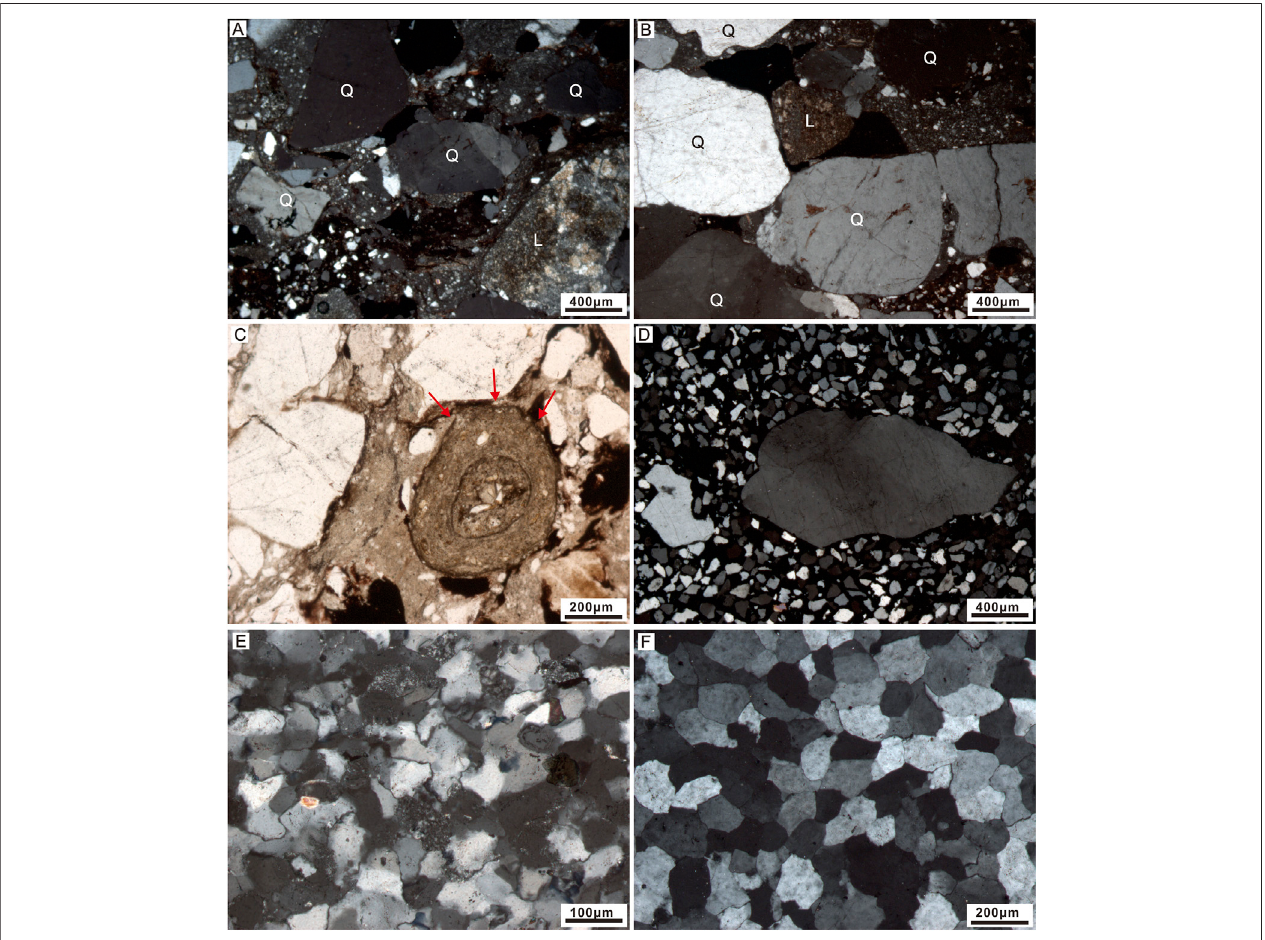
FIGURE 5 | Micrographs of sandstone samples from the Liangshan Formation. (A,B) Photomicrograph (cross-polarized light) of coarse-grained coastal plain channel sandstones from lower Xiuhe section, presenting high contents of silt-grained matrix, generally matrix-supported texture, and poorly sorted subangular to subroundedquartzgrains(Q)andsedimentarylithicfragments(L,carbonate,mudrock,andsiltstone)asframeworkcomponents. (C) Photomicrograph(plane-polarized light)ofcoarse-grainedcoastalplainsandstonesfromXiuhesection,showingaspeci fi cooid-likelithicfragmentwithdifferent-coloredconcentriclaminae(arrowed). (D) Photomicrograph (cross-polarized light) of fi ne-grained coastal plain channel sandstones in lower Xiuhe section, showing well-sorted, subangular to subrounded quartz grains and outsized quartz grains, which range from coarse-grained sand to granules in size. (E) Photomicrograph (cross-polarized light) of fi ne-grained deltaic sandstonesfromtheupperCaohaisection. (F) Photomicrograph(cross-polarizedlight)ofthe fi ne-graineddeltaicsandstonesinthemiddleMapojiaosection.Thedeltaic sandstones are dominated by generally well-sorted, subrounded quartz grains, which are sometimes coalesced together by diagenesis.